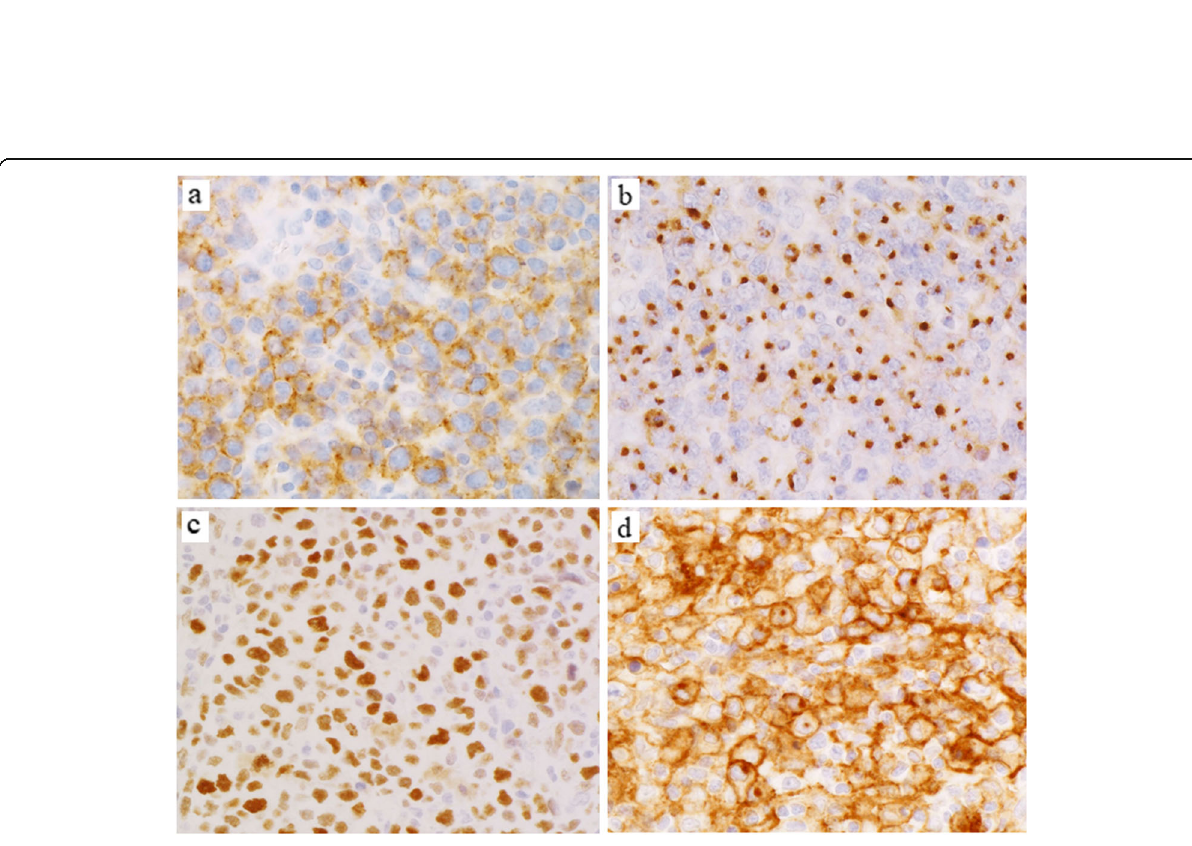
Fig. 2 Immunohistological findings of patients with large cell PTCL-TFH. Atypical large lymphoid cells are diffusely positive for PD-1 ( a ), CXCL13 ( b ), CMYC ( c ) and PD-L1 ( d ). PD-L1+ tumour cells, dendritic and histiocytic cells are admixed. Magnification, ×